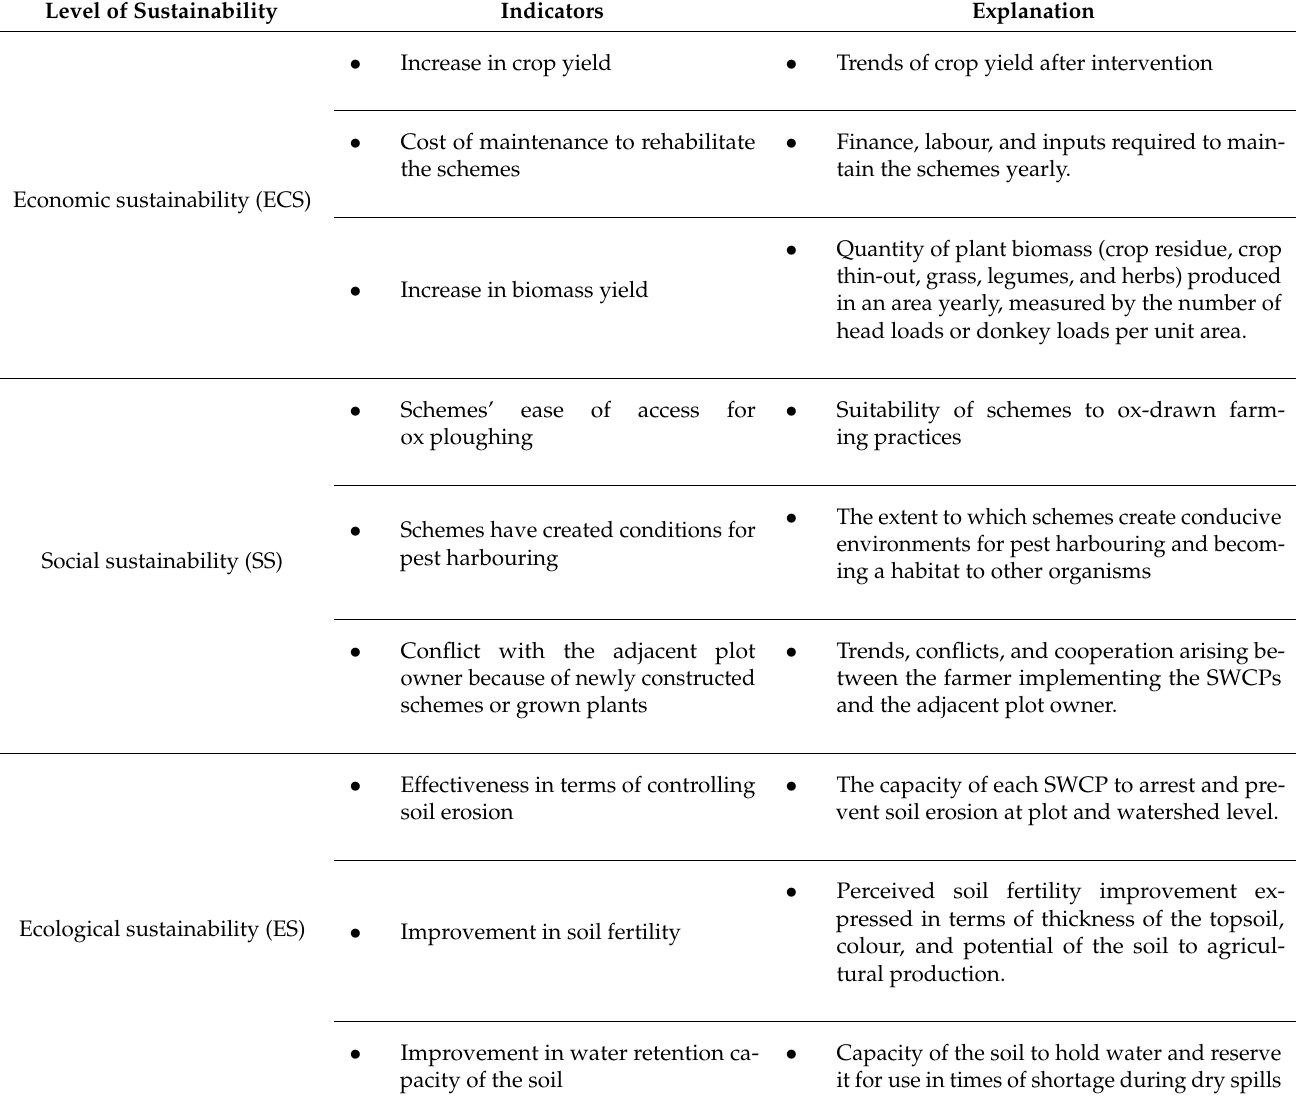
Table 5. Farm-level indicators for